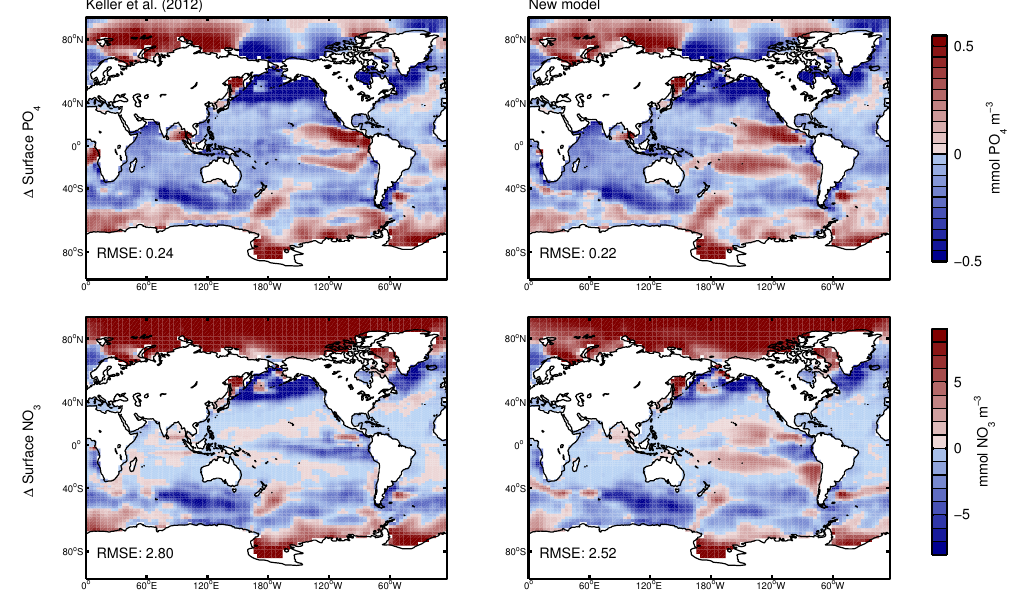
Figure 9. Difference between the annual mean surface WOA09 phosphate (first row) and nitrate observations (second row) and the values simulated with the model by Keller et al. (2012) and the new model.